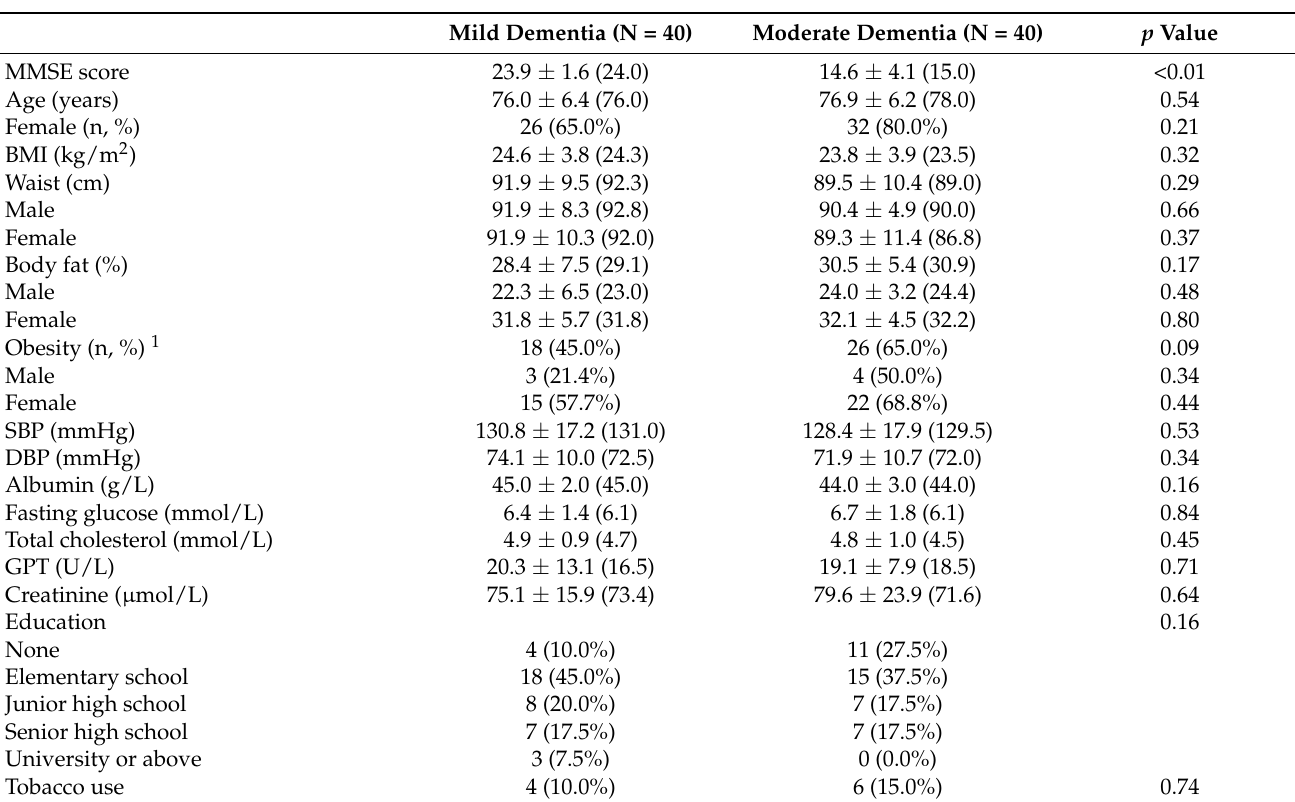
Table 1. Characteristics of patients with